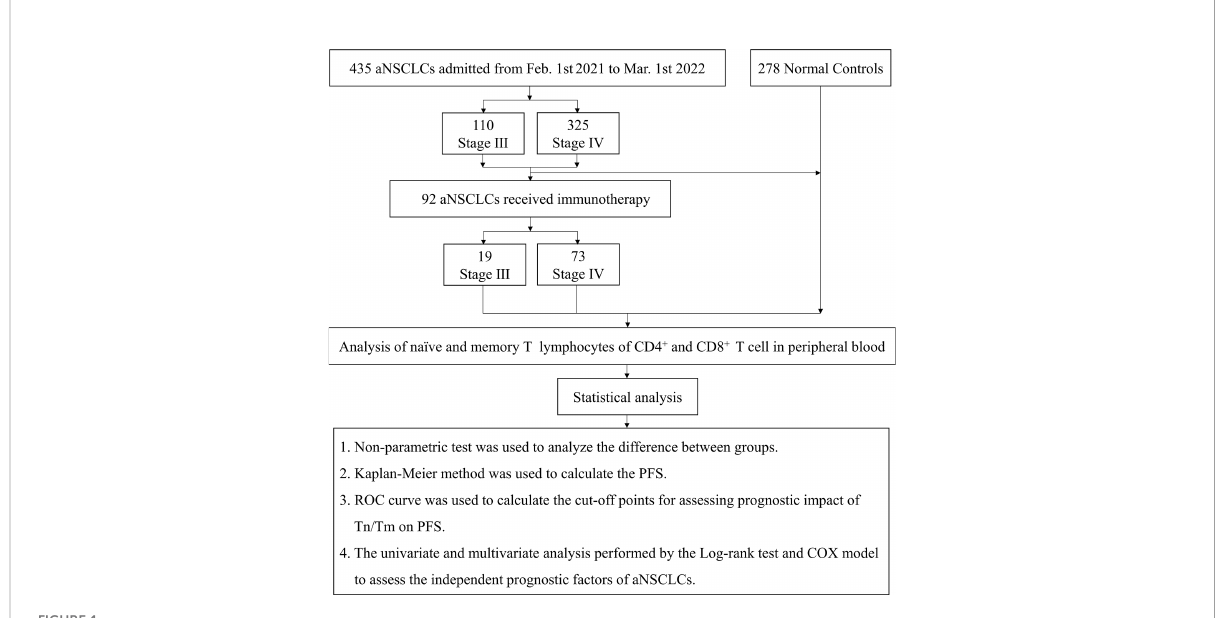
FIGURE 1 The fl ow chart of patient inclusion and analysis procedures in the